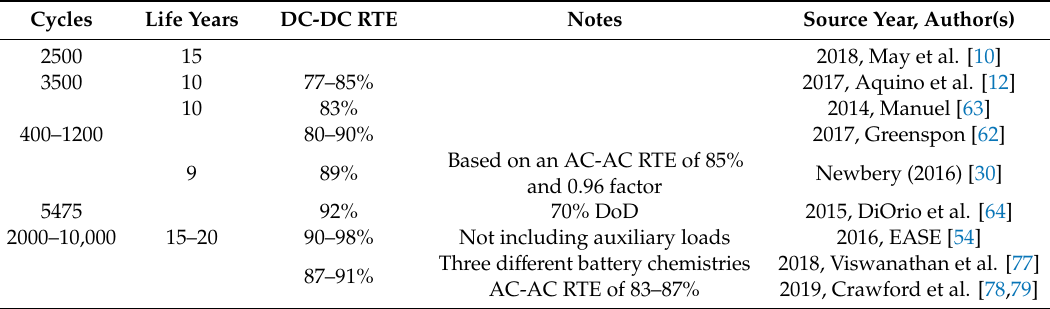
Table 14. Cycles, life years, and RTE—lithium-ion